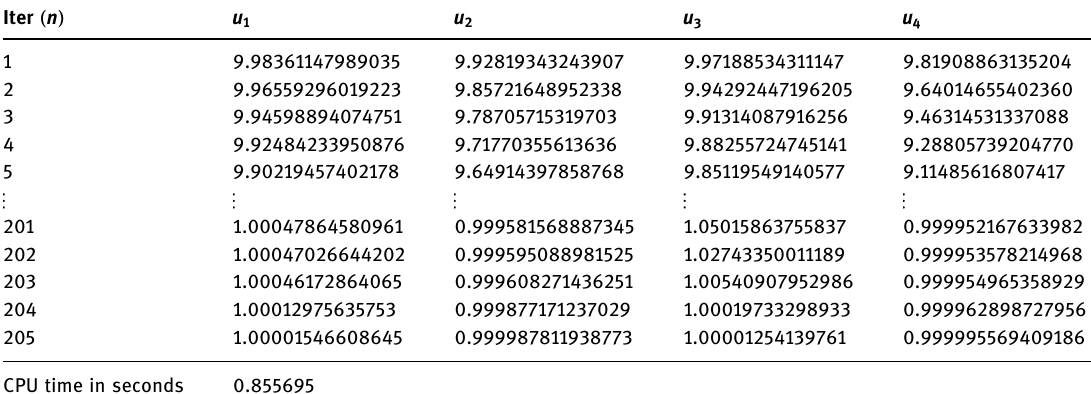
Table 2: Example 4.2: Numerical study of Algorithm 1 in [ 30 ]